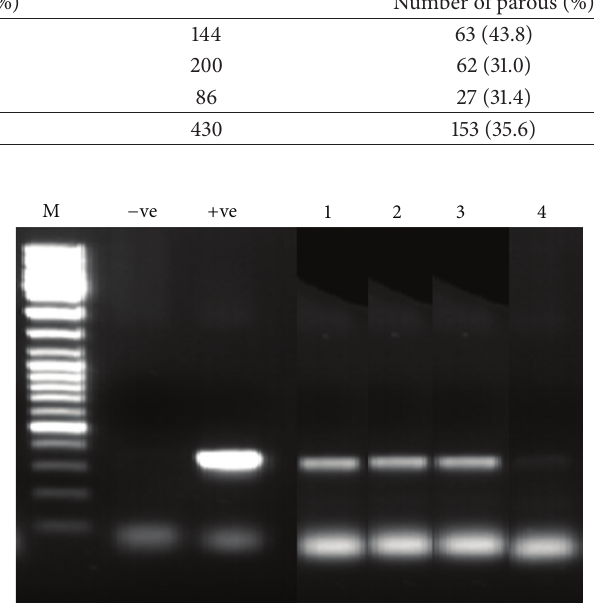
Figure 1: PCR of Leishmania internal transcribed spacer 1 (ITS1) region amplified from female sand flies. M: 100 bp size marker; − ve: negative control; +ve: reference Leishmania spp.; Lanes 1 and 2: L. donovani DNAs in P. orientalis and P. bergeroti females, respectively; Lane 3: L. donovani in S. africana ; Lane 4: Leishmania DNA in P. orientalis , but failed to be